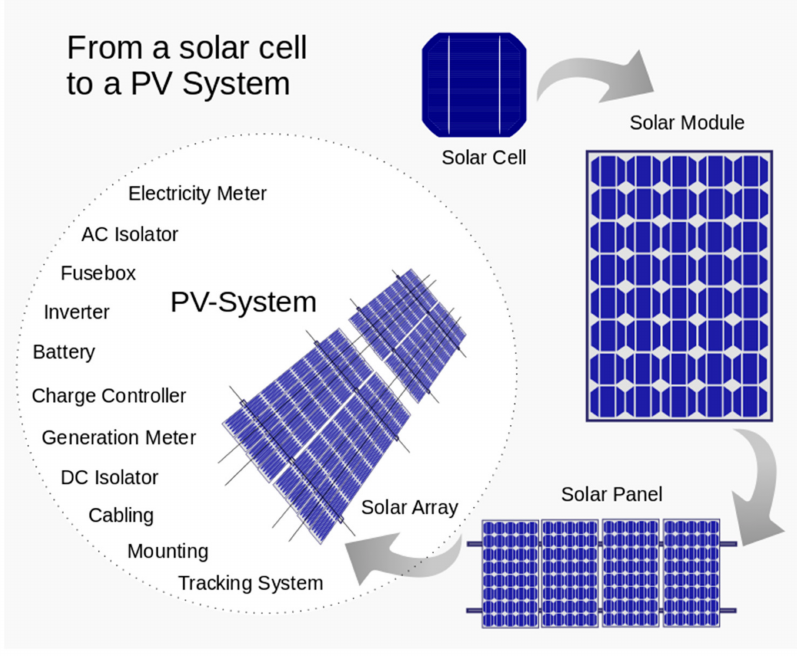
Figure 1. The process for transferring from a solar cell to a PV